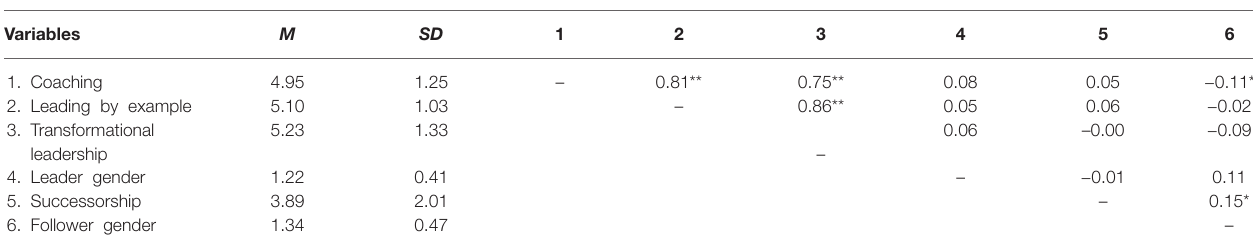
TABLE 1 | Descriptive statistics and Pearson zero-order correlations (study 1).